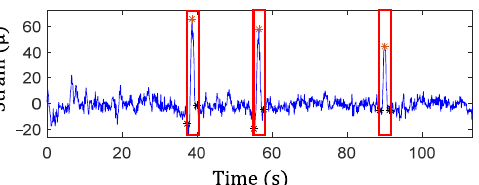
Figure 19. Identified traffic events and WOIs from strain, F ( t ) , measurement under multiple traffic events.